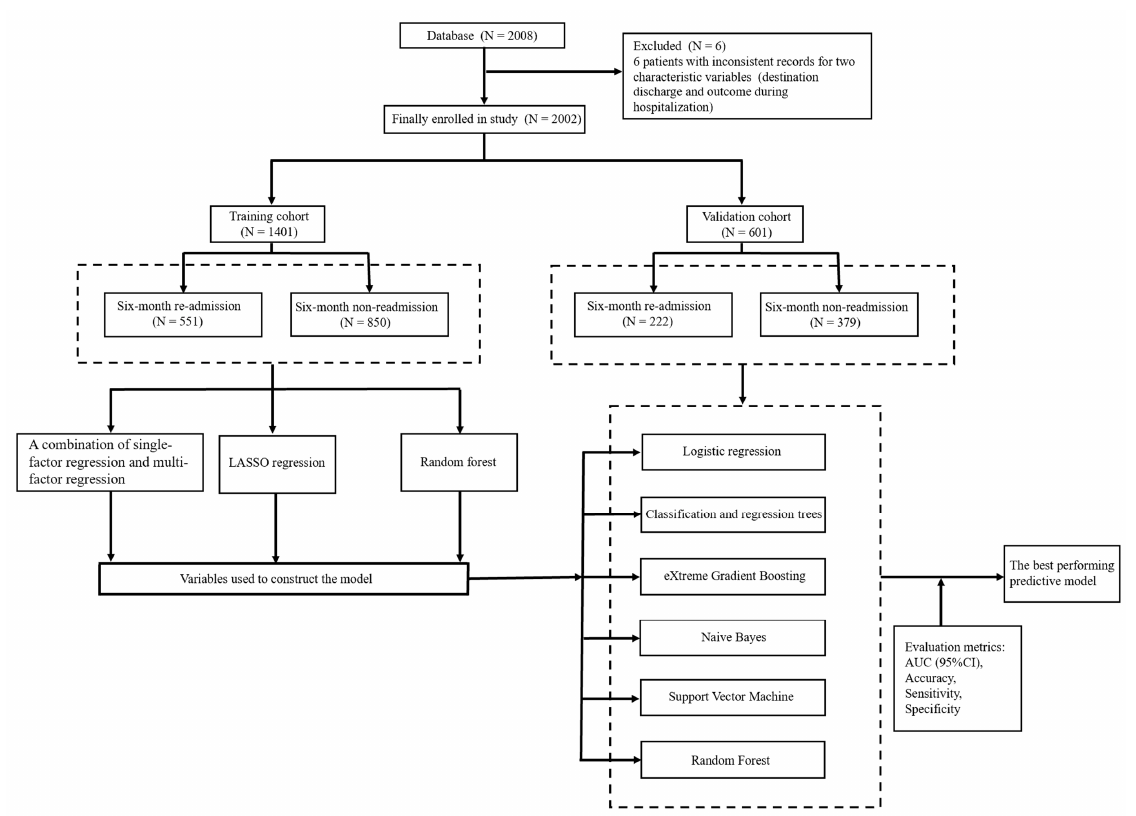
Figure 1. Study design. LASSO regression: least absolute shrinkage and selection operator regression; AUC: area under the curve; CI: confidence interval.